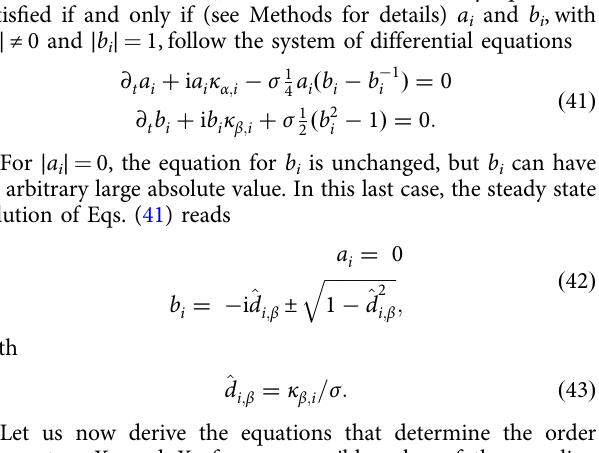
Fig. 8 The emergent frequency Ω E characterizing the rhythmic phase. The absolute value of the emergent frequency ∣ Ω E ∣ characterizing the rhythmic phase is shown as a function of σ , for networks of different network sizes N . The data is averaged over 100 realizations of the intrinsic frequencies along the forward transition. The equilibration time taken is T max ¼